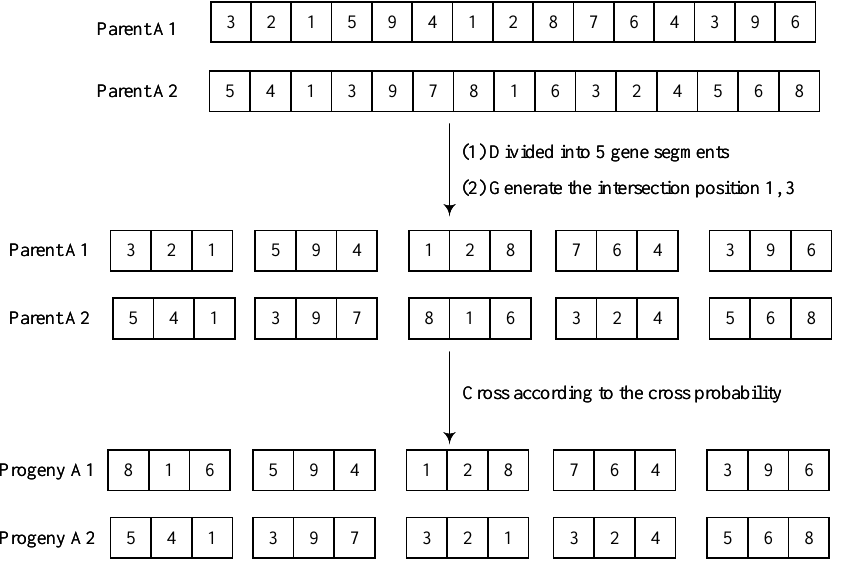
Figure 4. Crosstabs procedures.